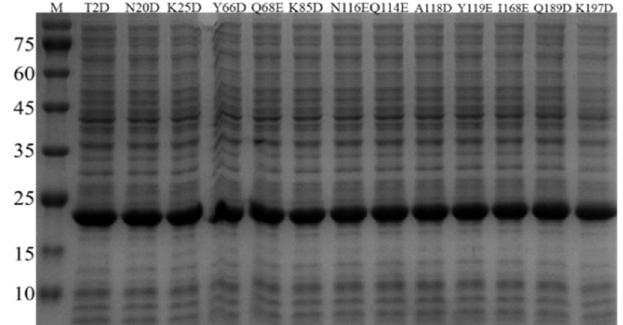
Figure 3. Protein expression analysis of variants on SDS-PAGE. The cell lysate was examined by SDS-PAGE under denaturing conditions, using the prestained marker (Takara, Japan) as the refer- ence.